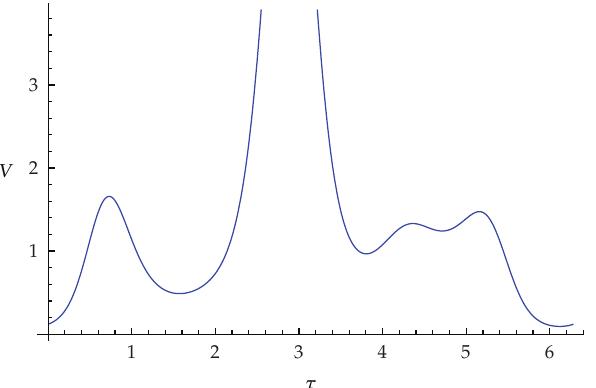
Figure 17: The evolution of the volume for the expression (cid:2) 4.11 (cid:3) with V 0 (cid:6) 1, t ∈ (cid:4) 0 , 2 π (cid:5) .